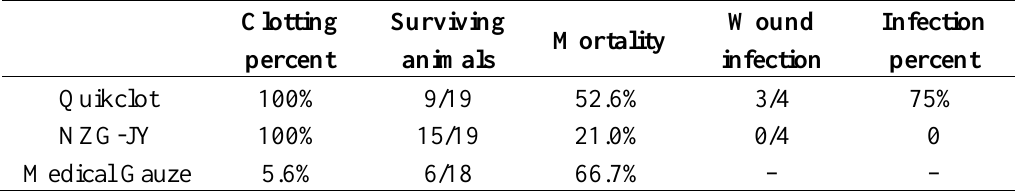
Table 1. Post-injury clotting percent, mortality and wound infection differences of the three